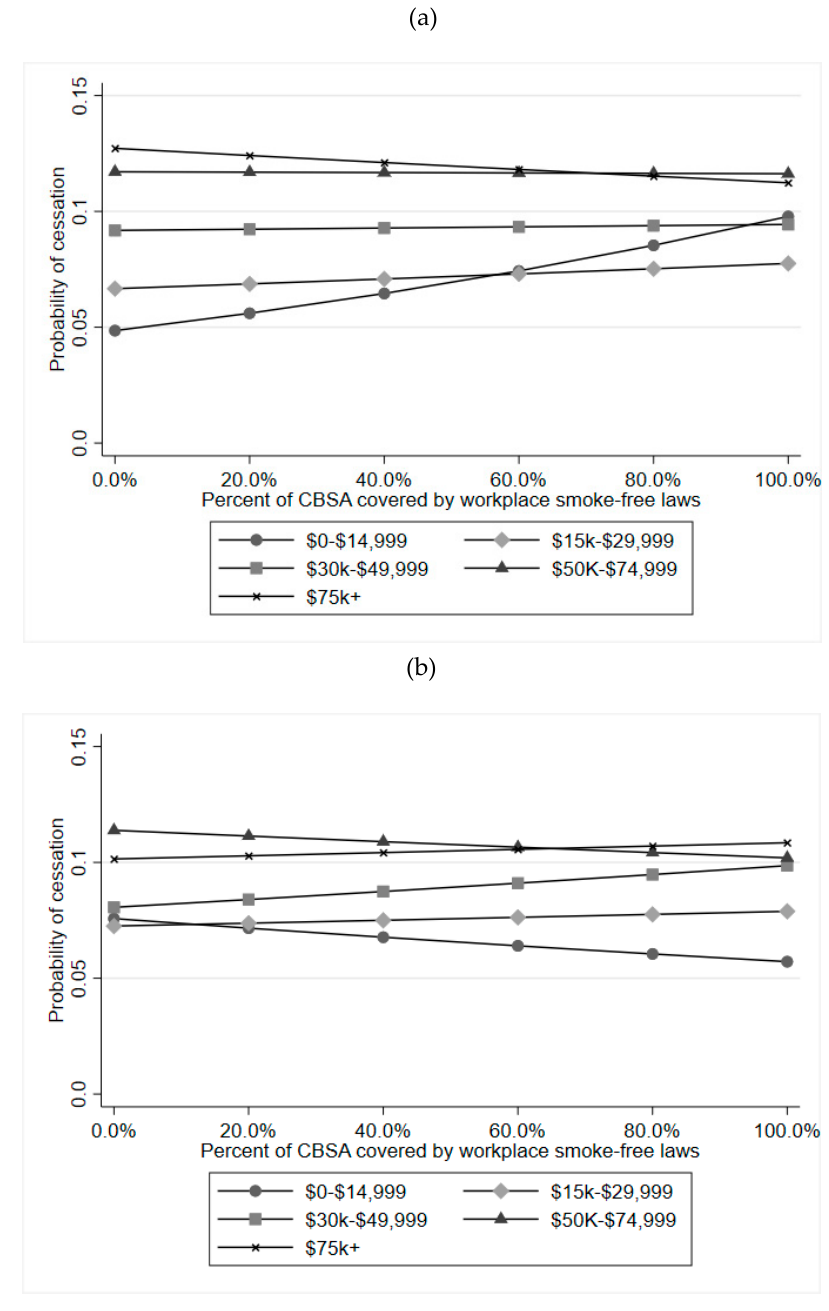
Figure 1. Predicted probability of cessation associated with workplace smoke-free law coverage by family income for ( a ) females and ( b ) males.